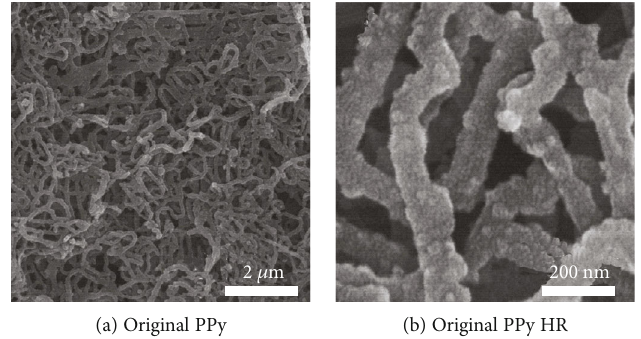
Figure 4: The microstructure of the original PPy (SEM).